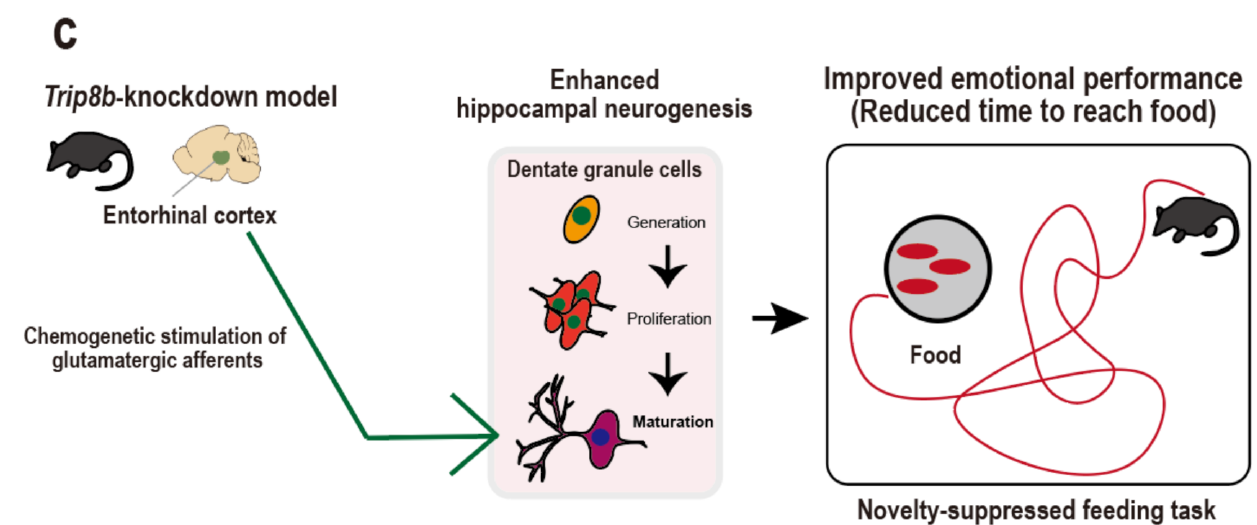
Figure 2. Supportive findings for entorhinal cortex-regulated hippocampal neurogenesis for cognition and emotion. ( a ), Entorhinal cortex-regulated hippocampal neurogenesis for memory function. Deep brain stimulation of the entorhinal cortex leads to increased neurogenesis, which presents as reduced time to escape in the water navigation maze task. ( b ), Entorhinal cortex-regulated hippocampal neurogenesis for pattern separation. Chemogenetic stimulation of the entorhinal cortex leads to enhanced neurogenesis in Trip8b -knockdown mice, which presents as improved discrimination between similar contexts in a fear conditioning task. ( c ), Entorhinal cortex-regulated hippocampal neurogenesis for emotion regulation. Chemogenetic stimulation of entorhinal cortex leads to improved neurogenesis in Trip8b -knockdown mice, which presents as an immediate response to a given food in the novelty-suppressed feeding